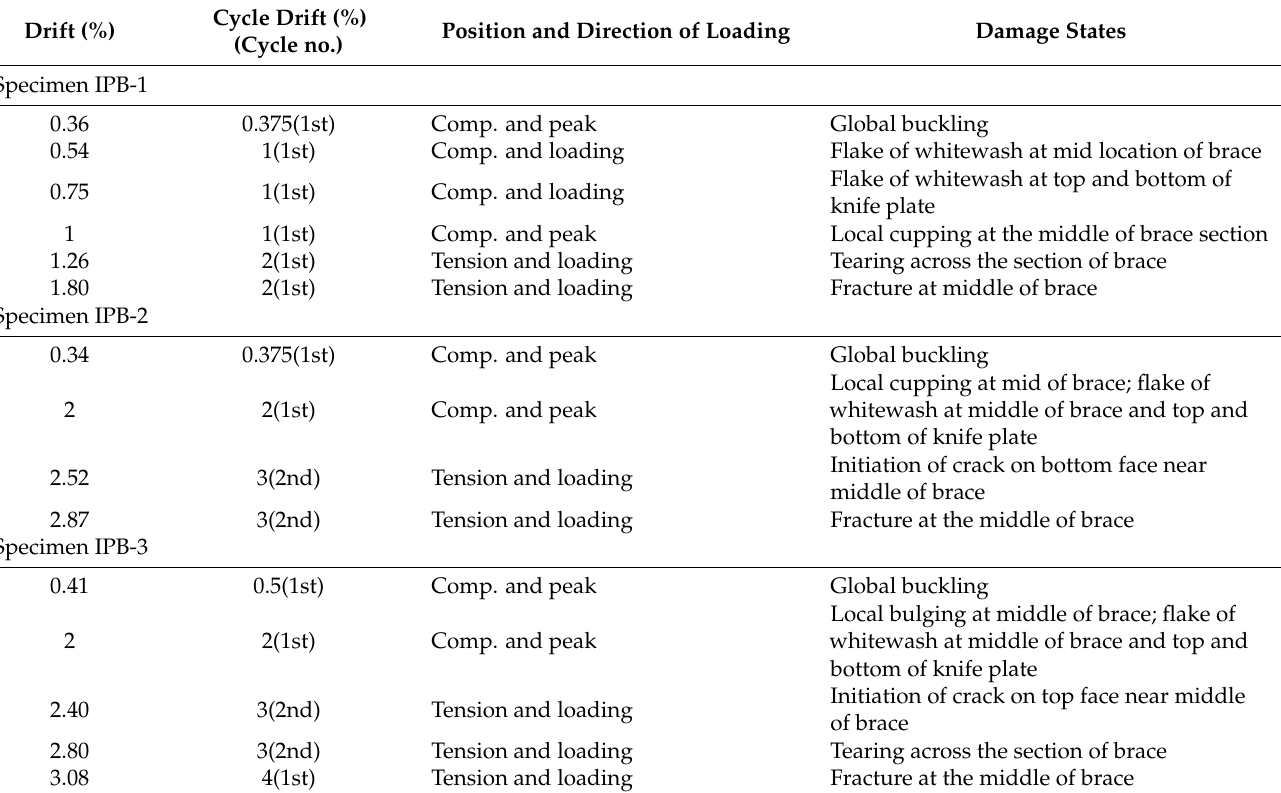
Table 3. Observation of various damage states of the IPB Braced